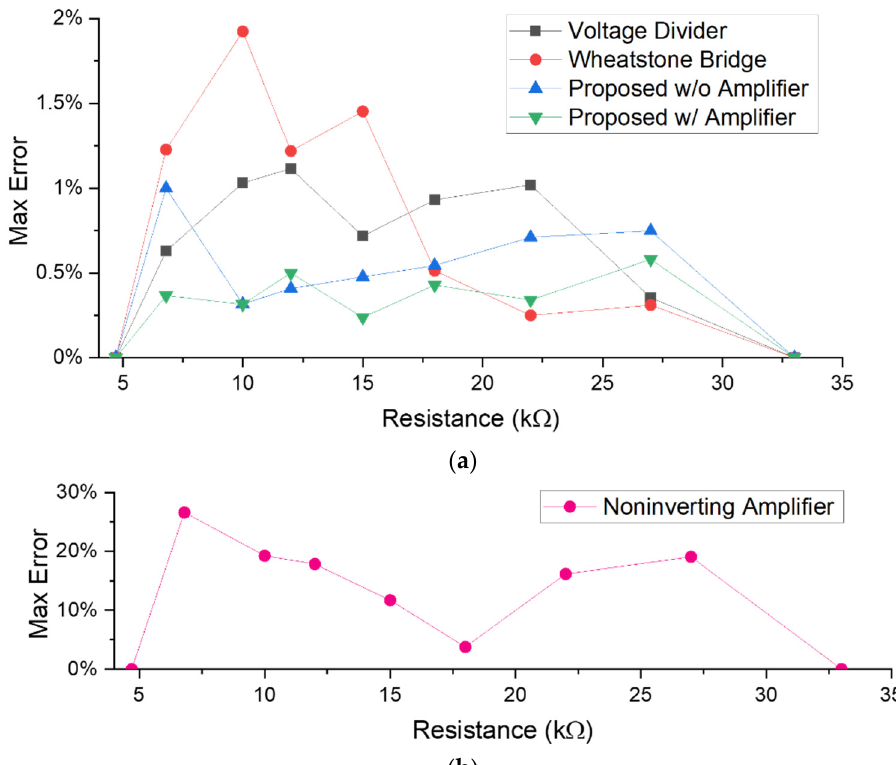
Figure 13. Maximum measurement error of each method from different input resistances: ( a ) voltage divider, wheatstone bridge, and proposed methods; ( b ) noniverting amplifier method.